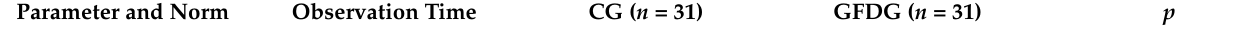
Table 3. Change in median concentrations ( ∆ ) of analyzed parameters between individual appointments ( n = 62). Parameter and